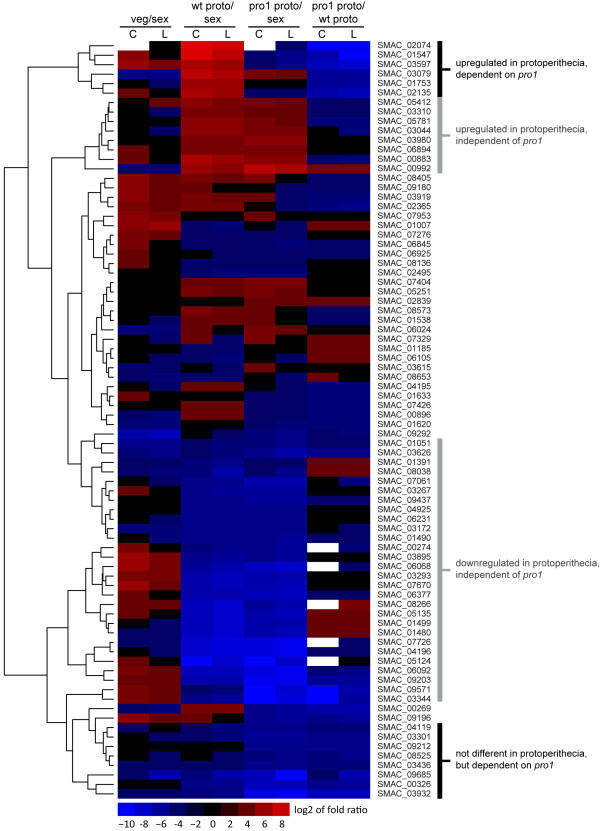
Expression of putative sugartransporter genes. Eighty genes contained at least on Sugar_tr domain. Hierarchical clustering and heatmap generation of the log2 of fold ratios as determined by classic (C) and LOX (L) analysis were perfomed in R.